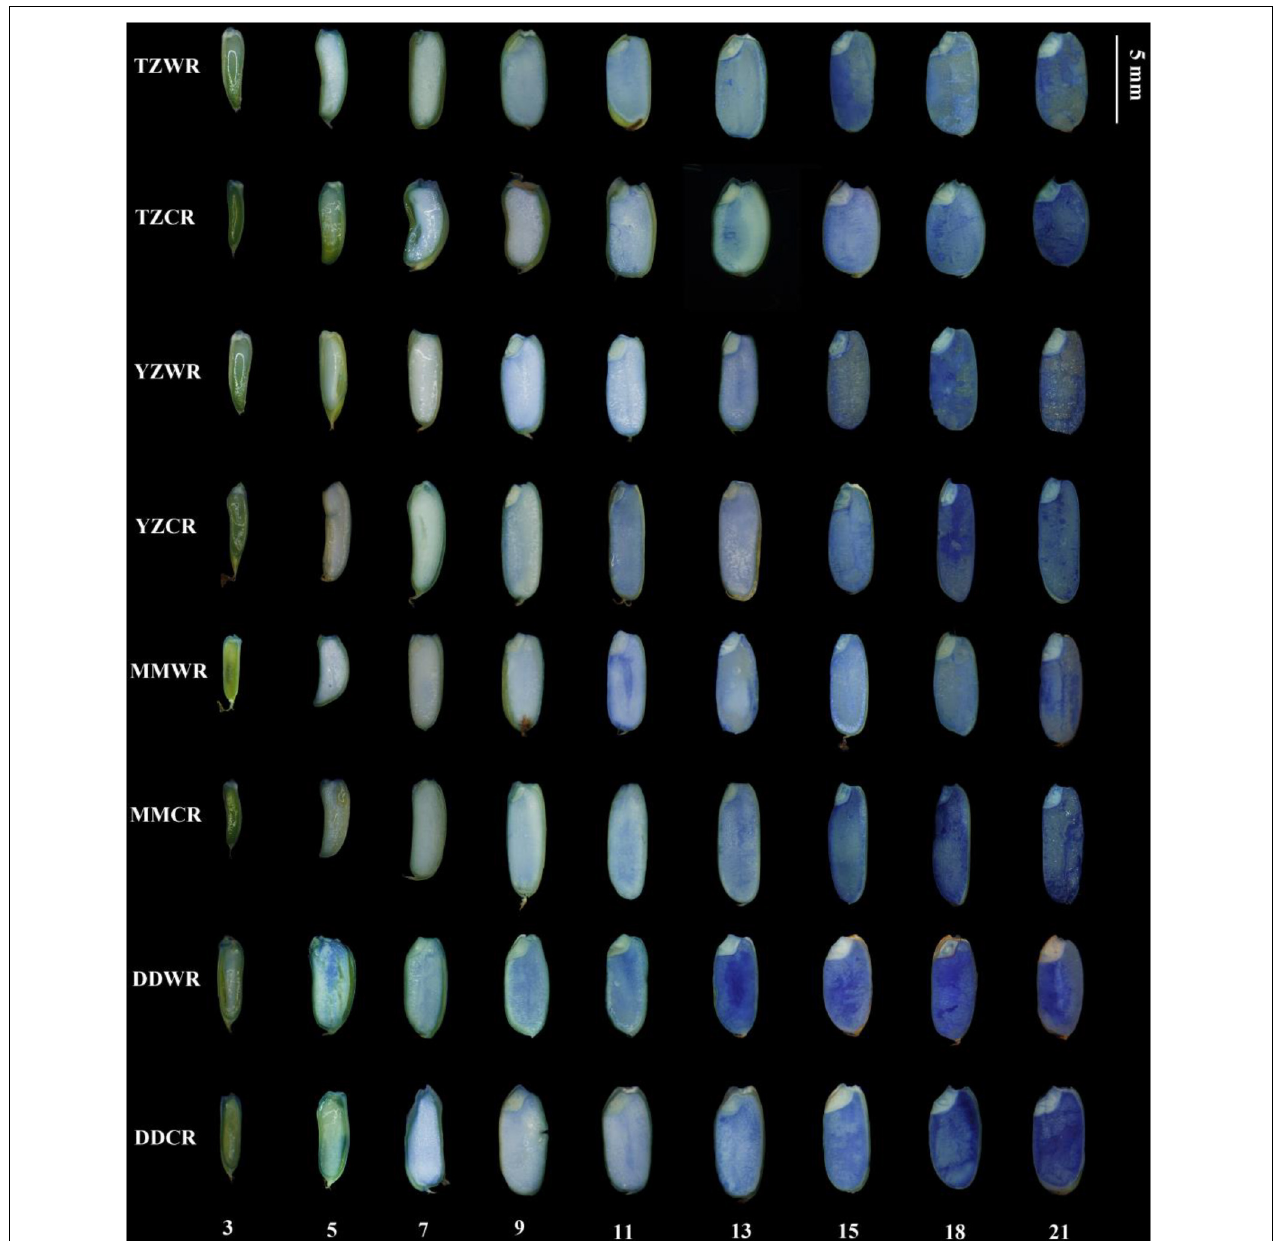
FIGURE 3 | Evans blue staining in developing grains of weedy and cultivated rice. TZWR, weedy rice from Taizhou; TZCR, cultivated rice from Taizhou; YZWR, weedy rice from Yangzhou; YZCR, cultivated rice from Yangzhou; MMWR, weedy rice from Maoming; MMCR, cultivated rice from Maoming; DDWR, weedy rice from Dandong; DDCR, cultivated rice from Dandong. The Roman numerals at the bottom of the picture represent the days post anthesis.